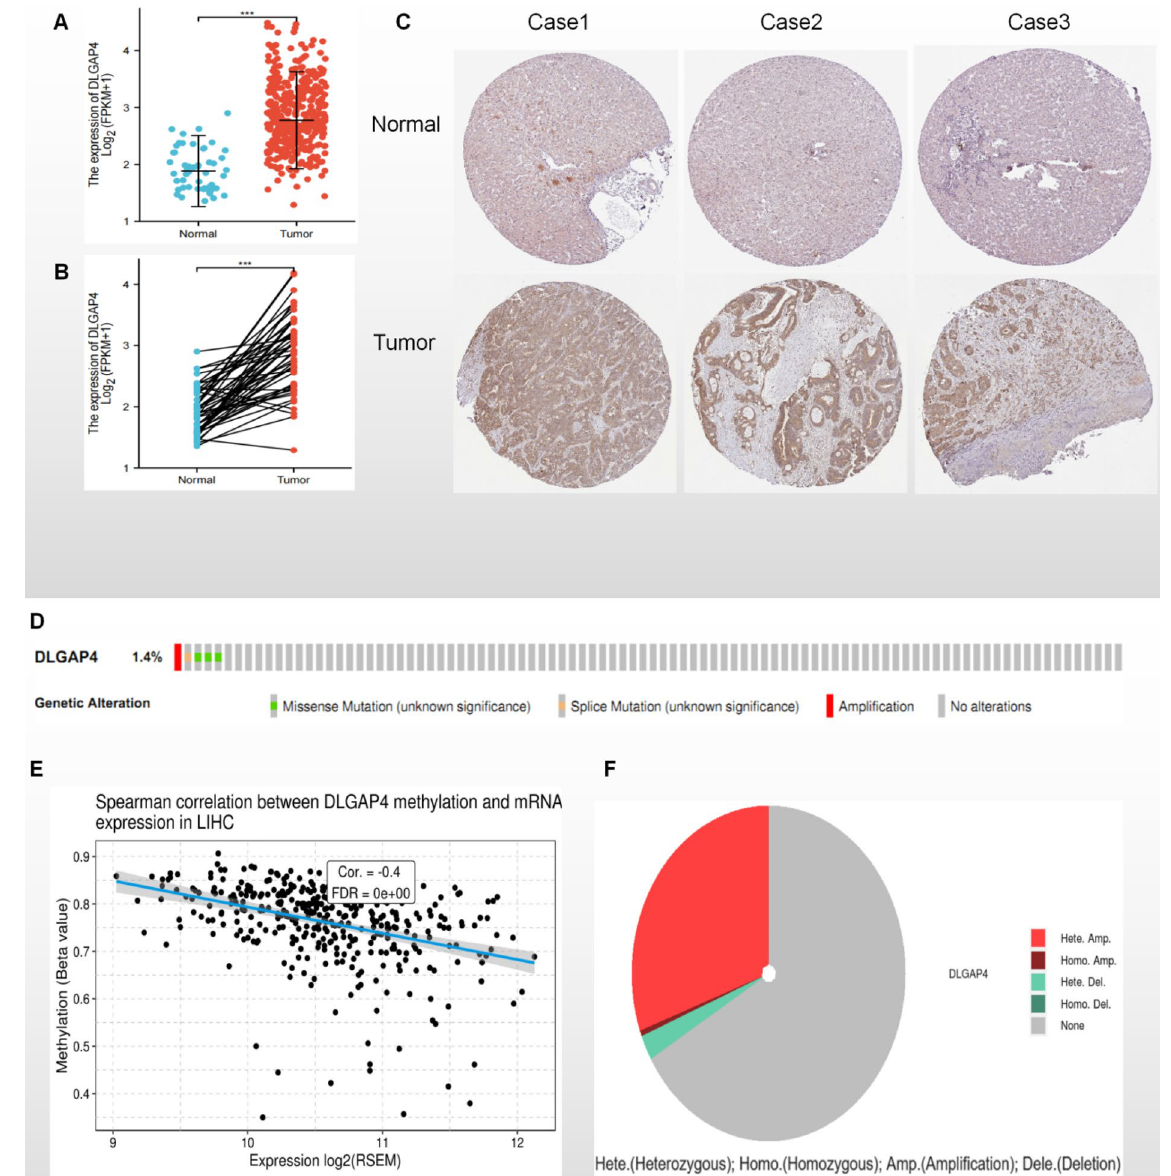
Figure 1. ( A ) DLGAP4 expression in normal and tumour tissues. ( B ) DLGAP4 expression in paired tissues. ( C ) Validation of the expression level of DLGAP4 in HCC using the Human Protein Atlas database (immunohistochemistry). ( D ) The cBioPortal OncoPrint map shows the distribution of DLGAP4 genome changes in HCC patients. ( E ) The GSCA database showed the correlation between methylation and DLGAP4 expression in HCC. ( F ) The GSCA database shows DLGAP4 copy number variation in HCC. *, ** and *** indicate P < 0.05, P < 0.01 and P < 0.001, higher than that in adjacent normal liver tissues (Fig. 1C). Furthermore, we analysed the Oncoprint map of HCC patient genes in the TCGA dataset by using the cBioPortal map (Fig. 1D), and the results showed that gene amplification and missense mutations of DLGAP4 were less than 1.4%. In addition, we analysed the differential expression of DLGAP4 in HCC via the GSCA database and found that it may be related to gene methylation modification and copy number variation (Fig. 1E,F). Overall, DLGAP4 is highly expressed in HCC. Correlation of DLGAP4 expression with clinical features. We next analysed the relationship between DLGAP4 mRNA expression levels and multiple clinical features of HCC patients based on TCGA database analysis. The results showed that the expression of DLGAP4 was significantly associated with AFP (P = 0.015), tissue grade (P = 0.008), BMI (P = 0.019) and body weight (P = 0.004) (as shown in Table 1). Further analysis showed that the expression of DLGAP4 was significantly associated with sex (P < 0.05), weight (P < 0.001), BMI (P < 0.01), AFP (P < 0.001), T stage (P < 0.01), histological grade (P < 0.001), pathological stage (P < 0.01), OS